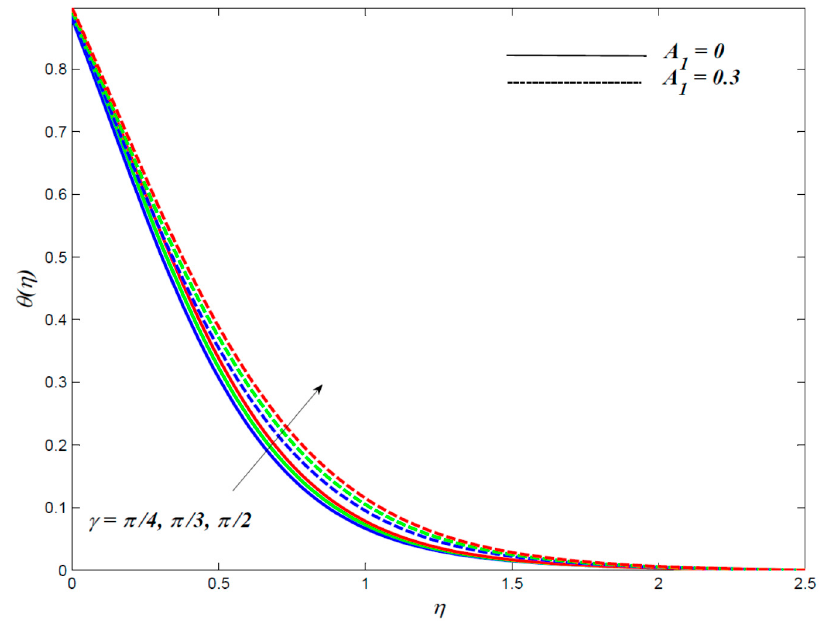
Mathematics 2020 , 8 , x FOR PEER REVIEW Figure 8. Temperature profiles owing to varying values of γ . Figure 8. Temperature profiles owing to varying values of γ .